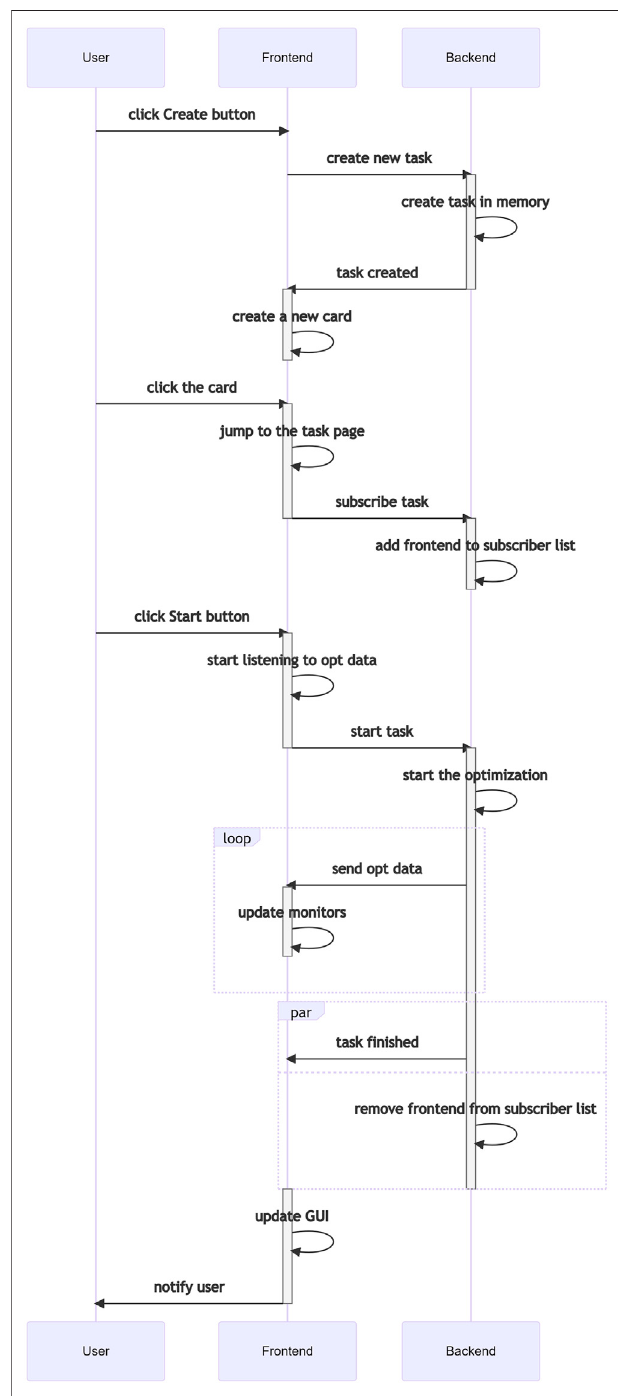
FIGURE 9 | Signal sequence when a user creates and runs an optimization task through the built-in Teeport GUI.